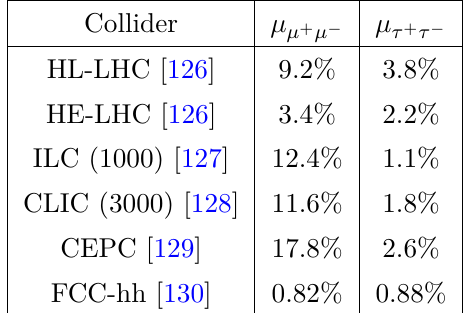
Table 1 . Expected relative precision of the Higgs signal strengths for future colliders. The numbers shown here are for the kappa-0 scenario of ref.